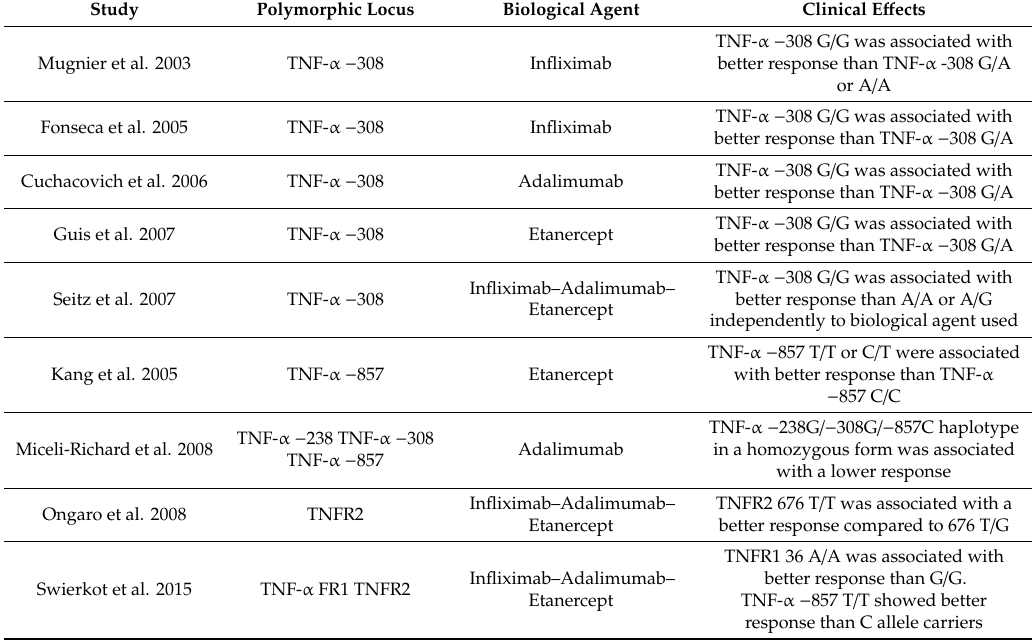
Table 1. Summary of studies on pharmacogenetics of anti-TNF treatment in